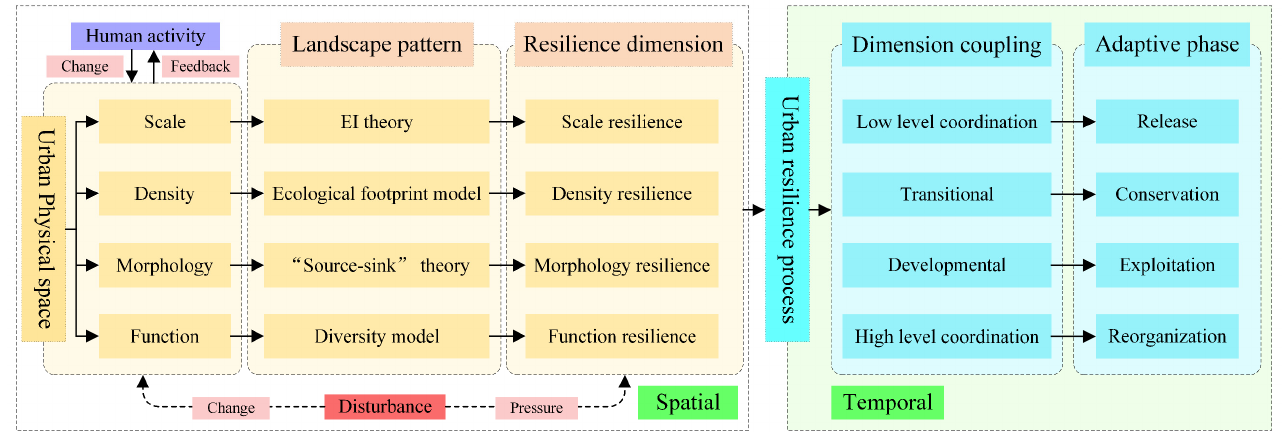
Figure 1. Theoretical framework for urban resilience based on the perspective of landscape pat- tern.